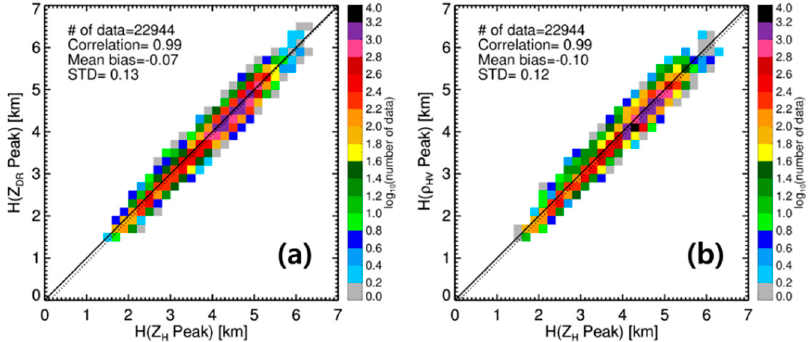
Figure 5. Two-dimensional frequency distribution ( a ) between H(Z DR Peak) and H(Z H Peak) and ( b ) between H( ρ HV Peak) and H(Z H Peak).